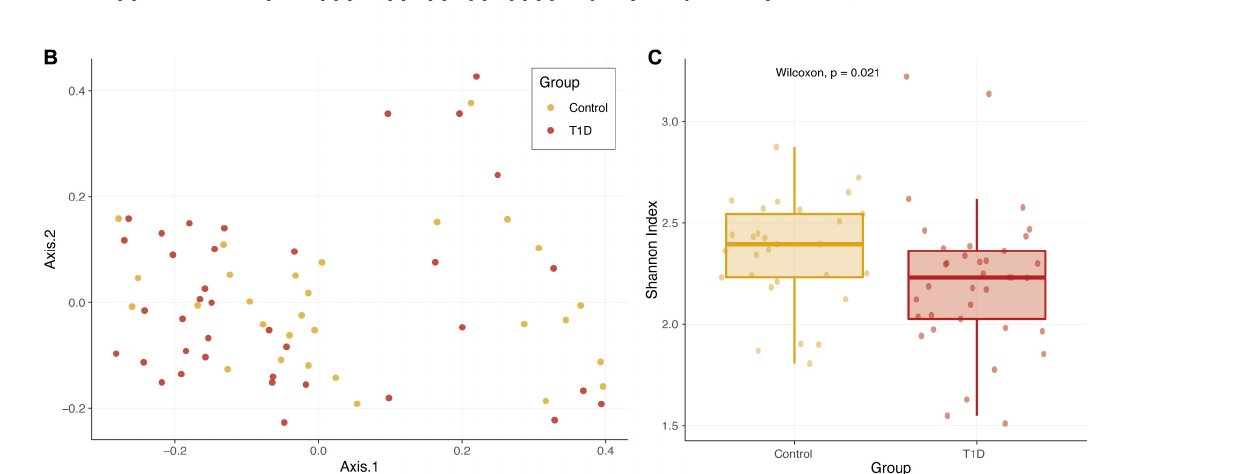
Frontiers in Microbiology |